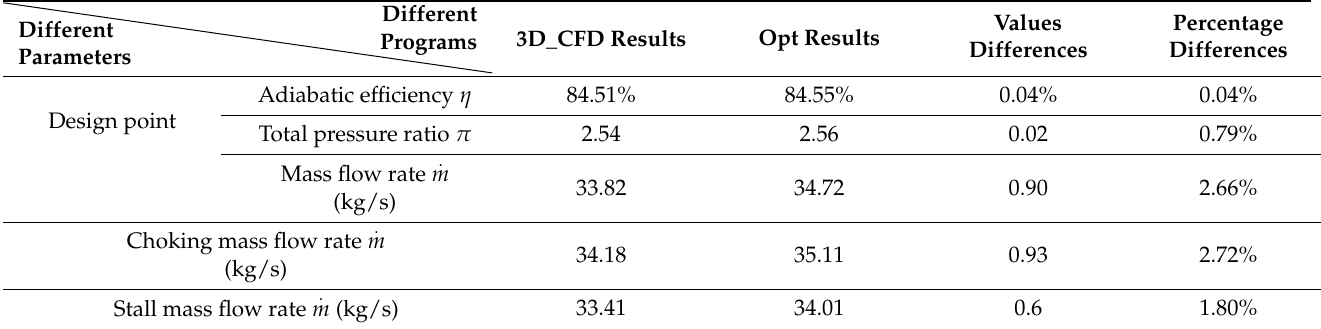
Table 4. The comparison of aerodynamic performance.